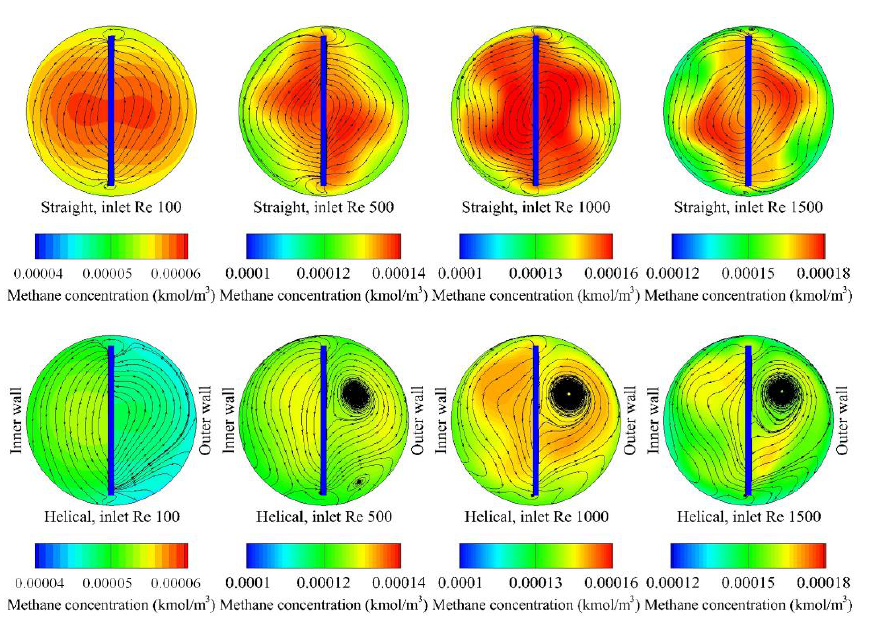
Figure 6. Methane concentration (kmol/m 3 ) and masslines of reactant flow in straight and helical reactors with insert tape twisting ratio of 3.15 at L = 25.16 mm and Reynolds number of 1000.